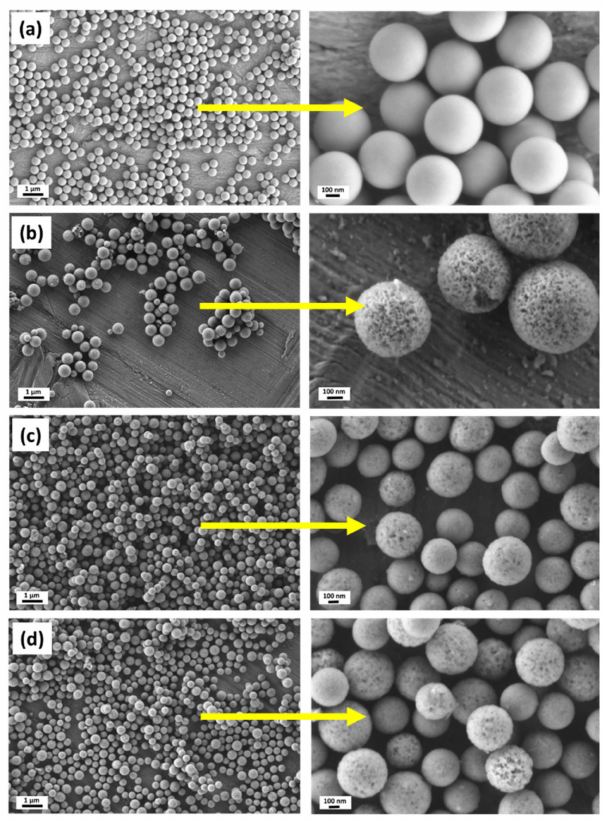
Figure 2. SEM images of ( a ) SiO 2 NPs; ( b ) HMSNs; ( c ) 1CaHMBGNs; and ( d )